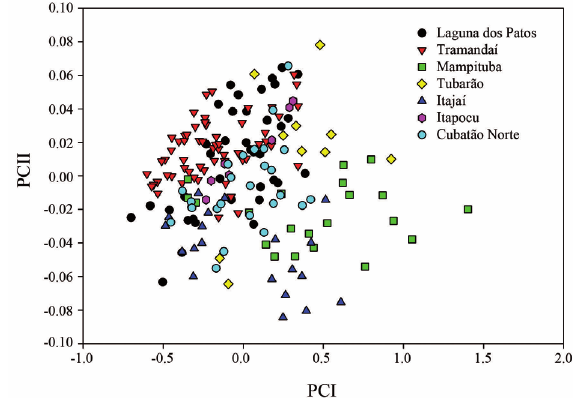
Fig. 13. Projection of individual scores in the space of first and second Principal Component axis for the populations of females of Astyanax laticeps .